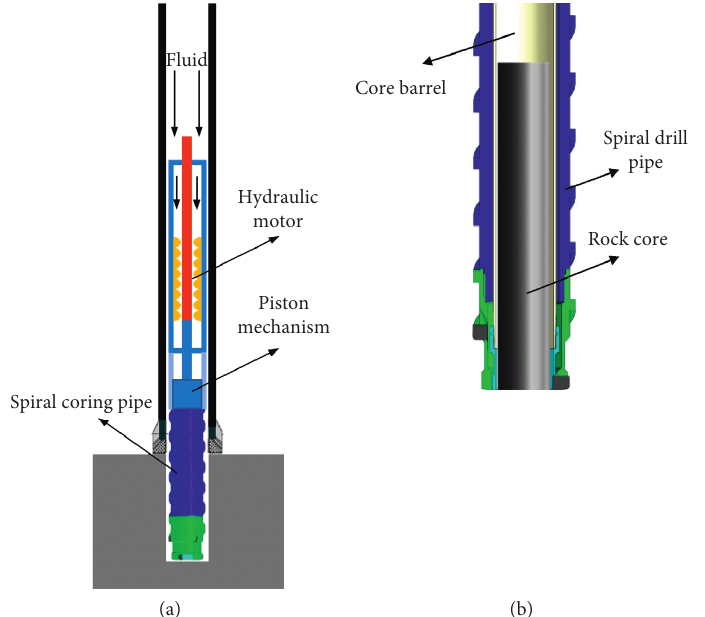
Figure 7: Innovative design of coring mechanism. (a) Self-advancing rotary drilling and coring. (b) Assembly relationship of drilling components.